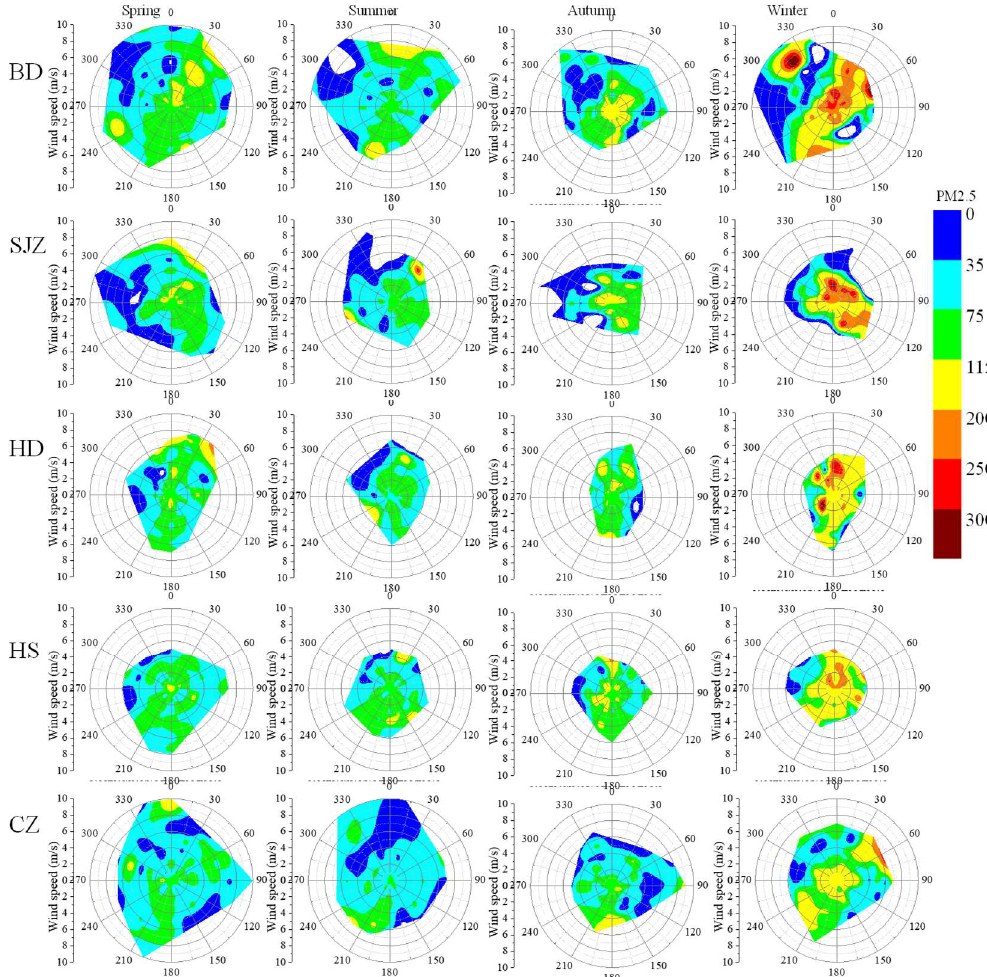
Figure 9. Maps of relationships between average PM 2.5 concentration and wind speed in five cities during 2013–2015.